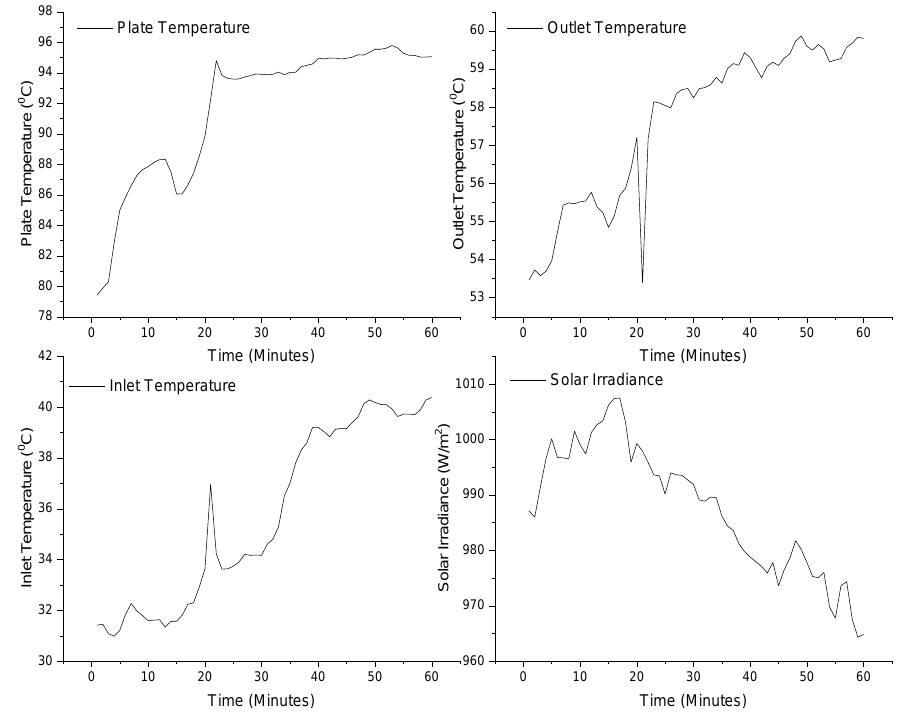
Figure 7. Graphical representation of different points temperatures and solar irradiance for parametric study of the solar air heater.